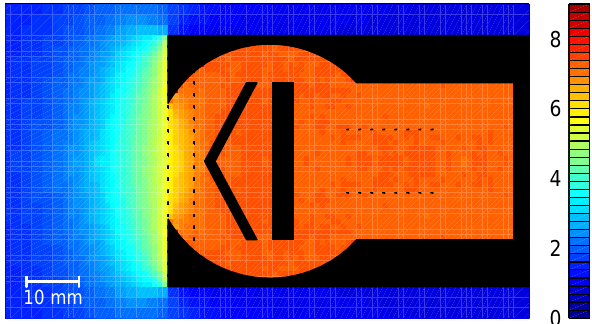
Fig. 5. Same as for Fig. 4 but for the TOTAL ionization